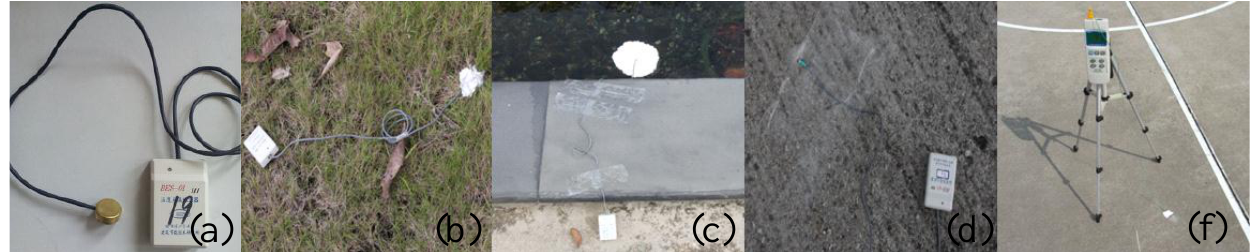
Figure 7. Synchronous field temperature measurement: ( a ) BES-1; ( b ) lawns; ( c ) water bodies; ( d ) asphalt pavements; and ( f ) concrete